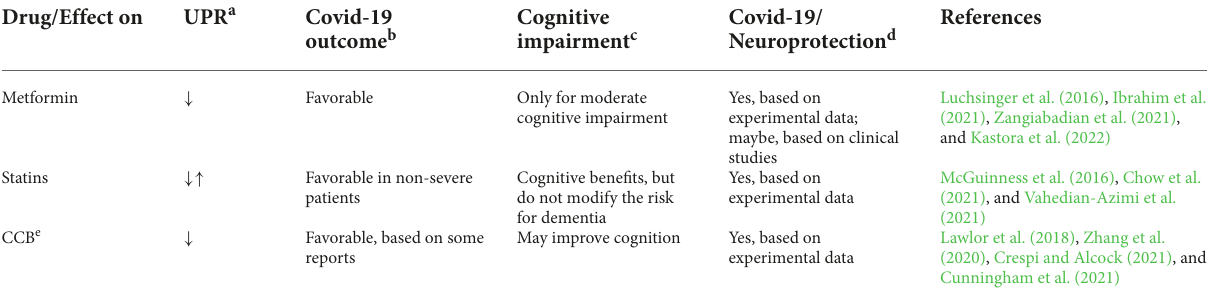
TABLE 1 Potential neuroprotective effect of drugs prescribed to diabetic patients.